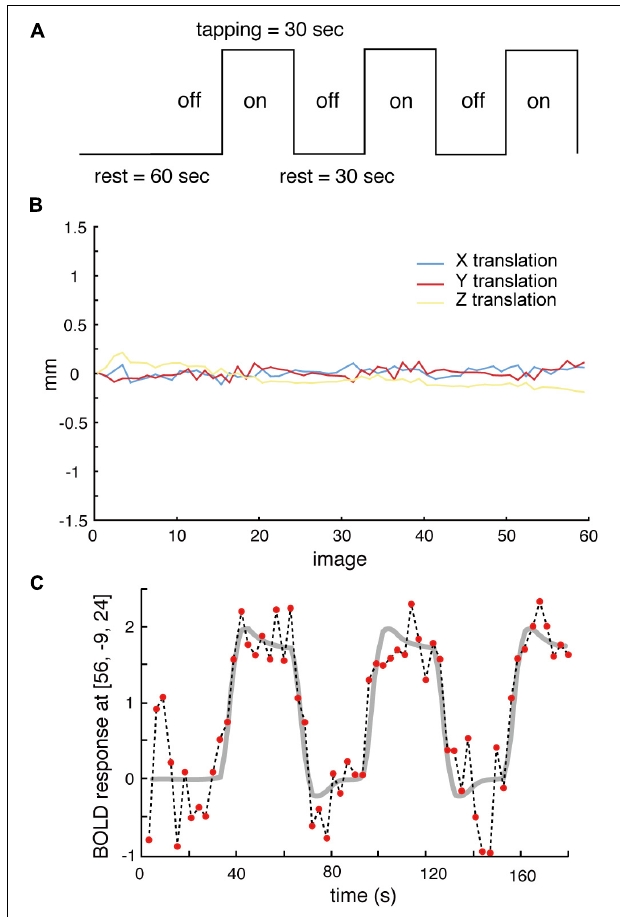
FIGURE 1 | (A) The task paradigm is represented by periods of teeth tapping. During the measurements, subjects alternated between 30 s of rest (off) and 30 s of tapping (on). The on–off cycle was repeated three times during each scanning run. (B) All data from subjects whose heads were evaluated to have moved > 1 mm, as determined by a free software package (SPM8) that calculated head motion, were discarded. (C) Example BOLD signals sampled at the MI [56, − 9, 24] from one participant. Changes in signal intensity with time on an image-by-image basis 60 successive images during three cycles of tapping. The vertical axis shows the BOLD signal intensity in arbitrary